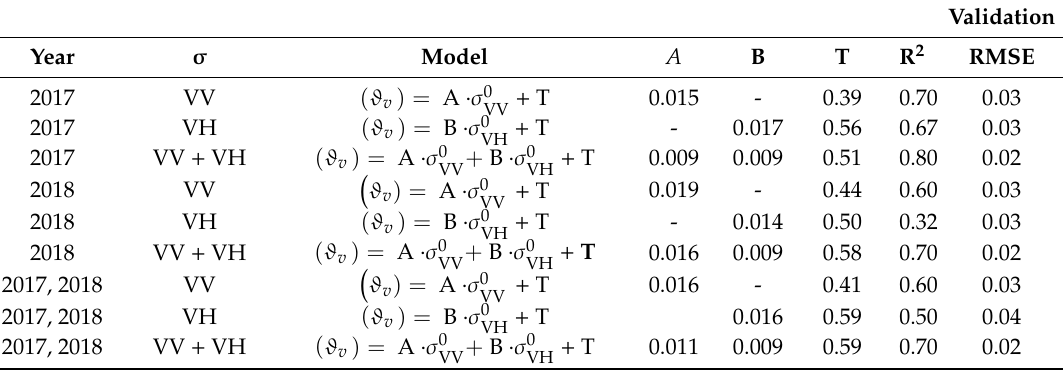
Table 6. Empirical constants (A, B, and T) of the generalized model. The total number of samples for 2017 was 368, for 2018 it was 427, and for a combination of 2017 and 2018, it was 795. The linear equations were derived using 70% of the total sample of each year and combined